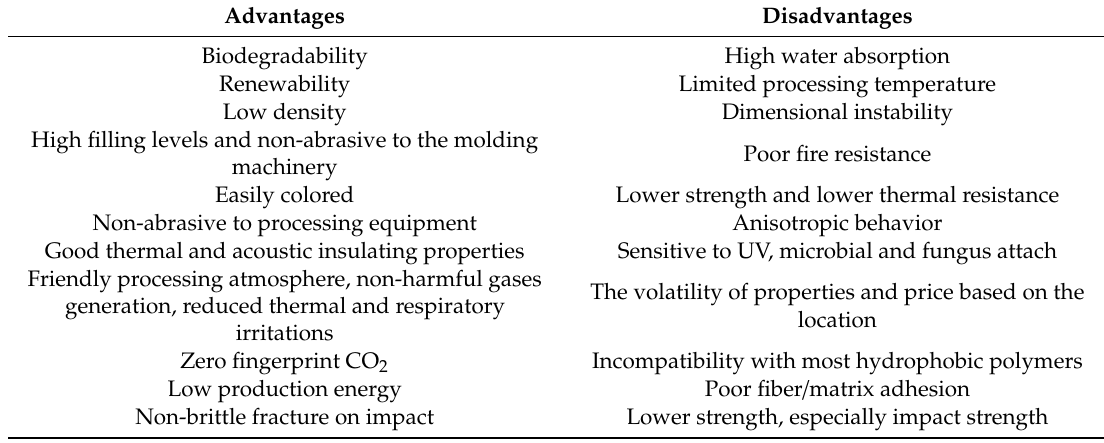
Table 3. Natural fibers’ advantages and disadvantages. Adapted from